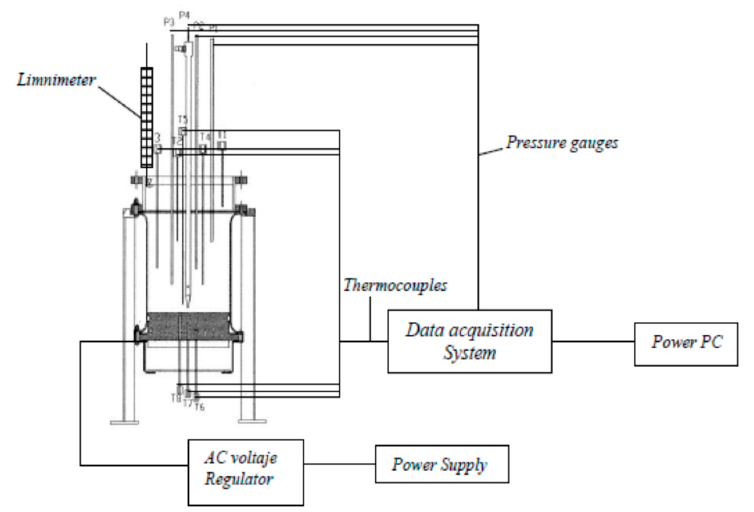
Figure 3. Scheme of the experimental set-up.